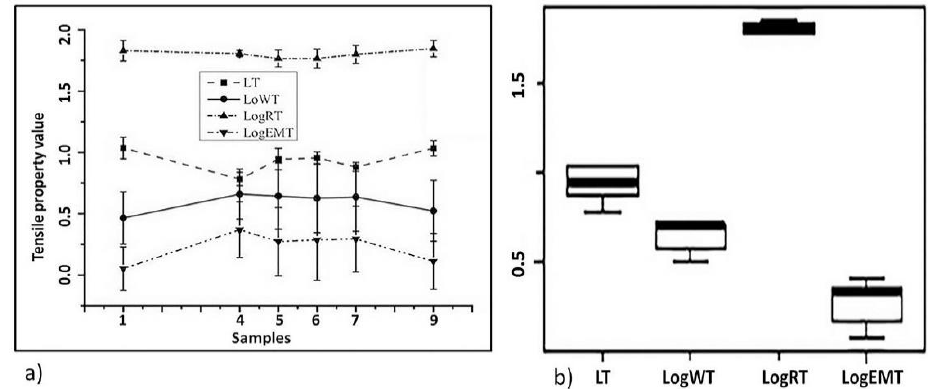
Figure 3. ( a ) The tensile properties measurement result and ( b ) the variability of the tensile measurements within the samples using box plot. The logarithmic values of some of the mechanical properties are used to draw the figure for scale purposes only. The polyester fabric treated with different functional finishings shows a variation of tensile parameters, which indicates that finishing affects the tensile properties and hence the tactile properties of textile fabrics.